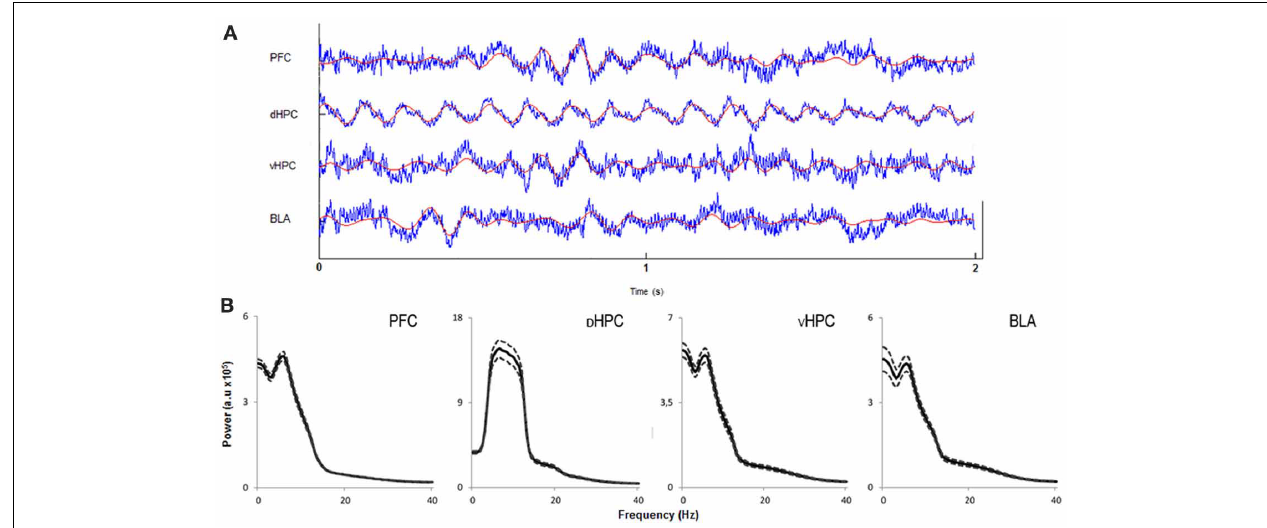
FIGURE 3 | Characterization of local field potentials recorded in the OF arena. (A) Representative traces from local field potentials simultaneously recorded from the medial prefrontal cortex (PFC), dorsal hippocampus (dHPC), ventral hippocampus (vHPC), and basolateral amygdala (BLA) in one rat exploring the OF arena during the first exposure. Raw traces are plotted in blue and filtered theta traces (5–12Hz) are overlayed in red. Presented